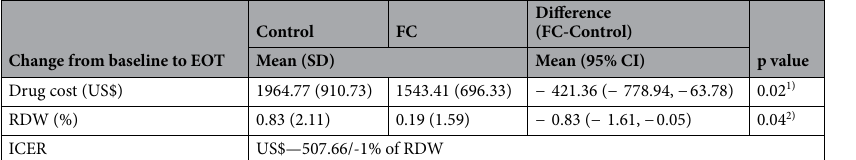
Table 5. Incremental cost effectiveness ratio (ICER). (Mean) 1) Student’s t test, 2) ANCOVA (covariate: baseline).